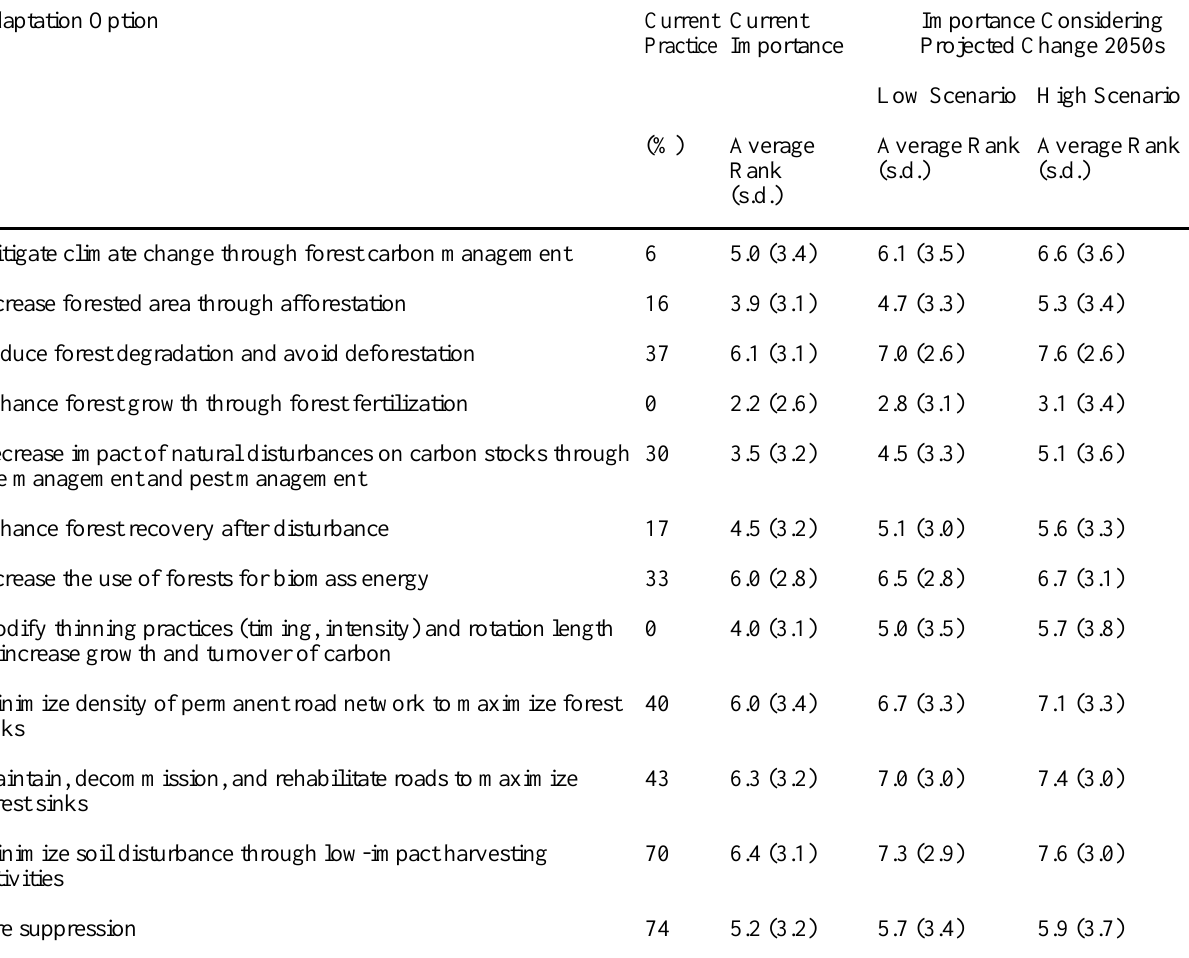
Table 8. Judgments of forest practitioners on the importance of adaptation options to conserve and maintain soil and water resources in forest ecosystems in the Champagne and Aishihik Traditional Territory for each of three scenarios: “current climate conditions,” “low scenario of future climate change by the 2050s,” and “high scenario of future climate change by the 2050s.” Scale of 1 to 10 (0 = no importance, 1 = low importance, 10 = high importance) or don’t know. Results shown are the average rank and standard deviation (s.d.) of participants who provided a ranking. The percentage of participants who agree or strongly agree with the statement “this management option is currently being practiced in the Yukon” is also provided. Adaptation options in bold are considered to be “no-regrets” (option is ranked 7 or higher across range of